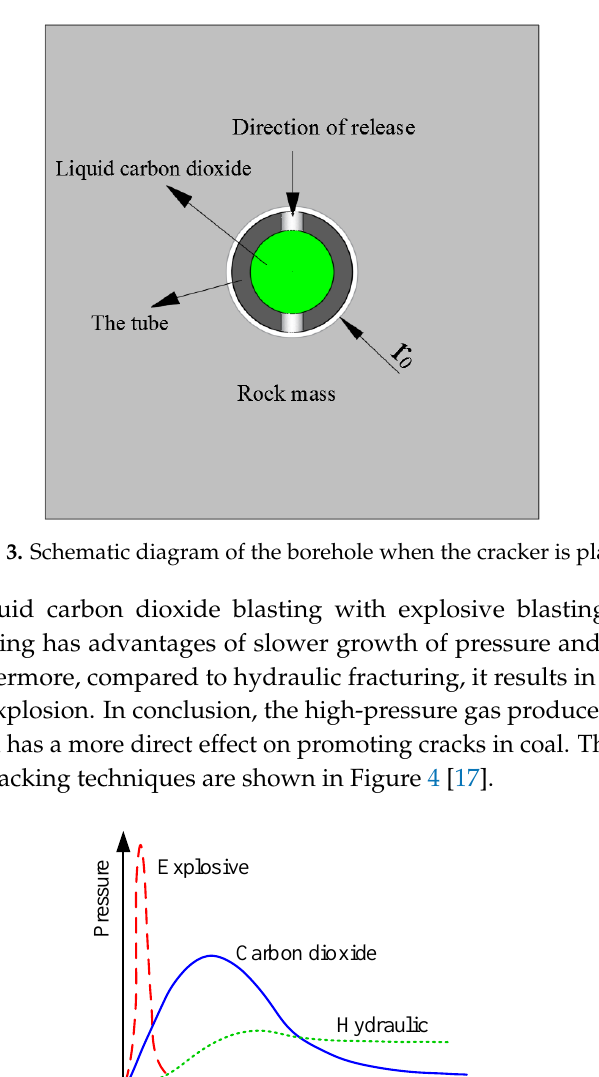
Figure 2. Cross-sectional diagram of cracking pipe: (1) charging valve; (2) heating element; (3) storage tube; (4) constant stress shearing sheet; (5) seal rings; (6) release hole.